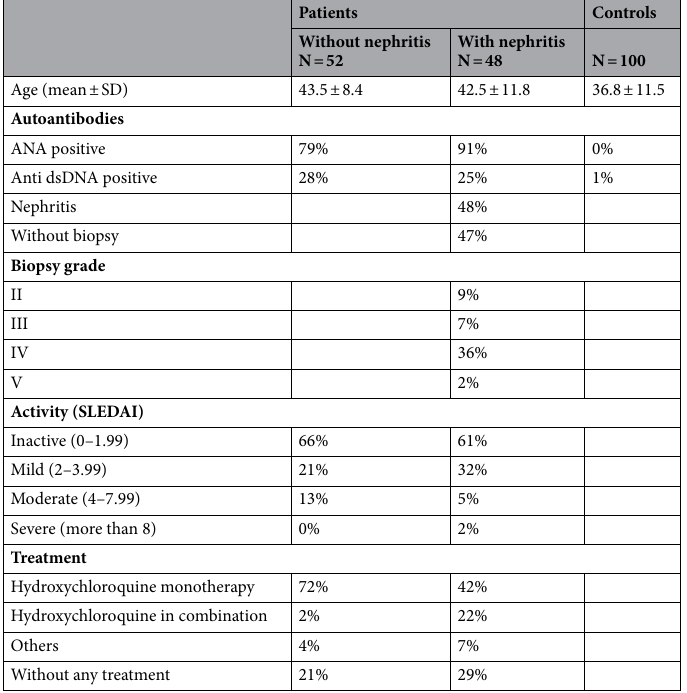
Table 1. Patient and control